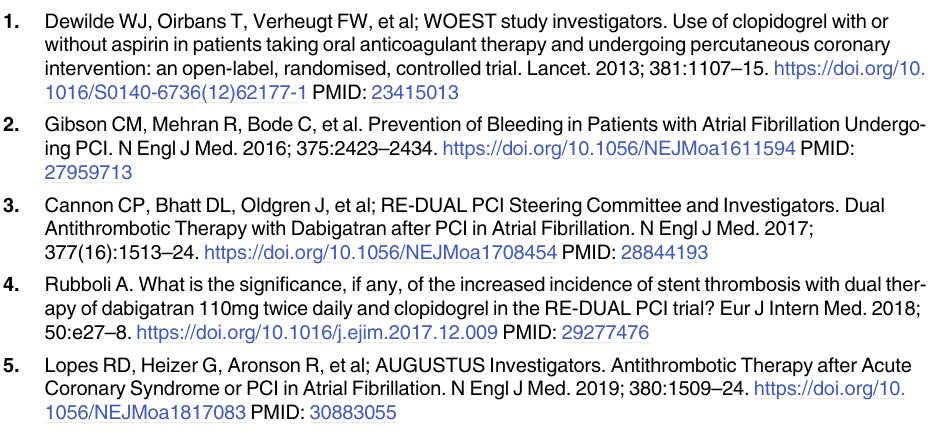
S1 Table. Risk of bias of individual studies by Cochrane risk assessment